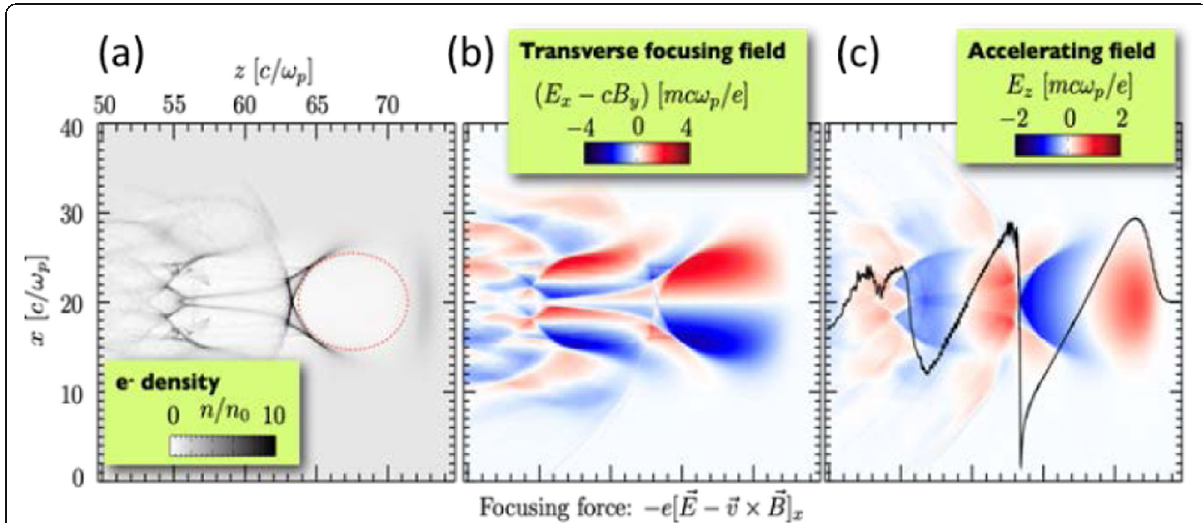
field for the electrons, and c shows the longitudinal electric field distribution